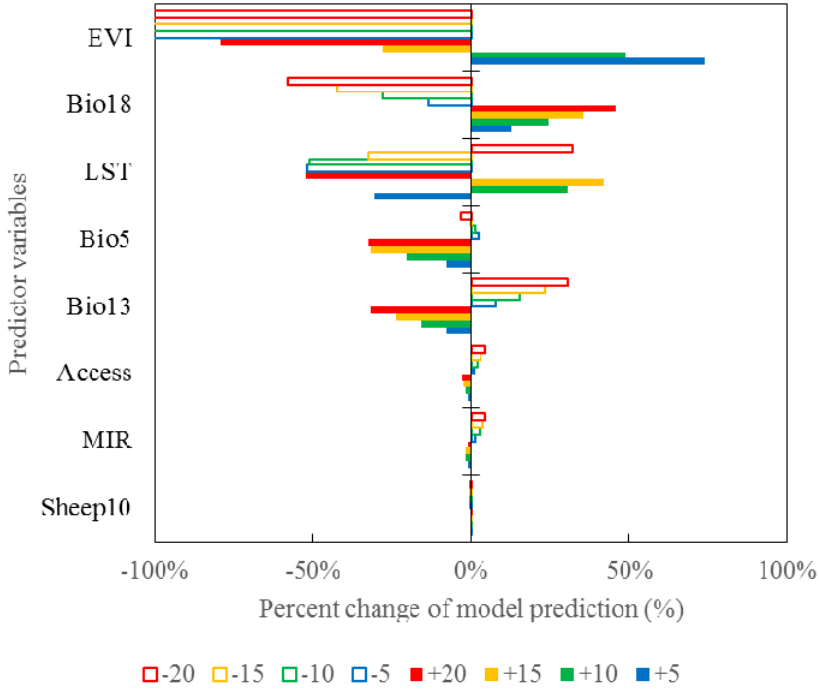
Figure 8. Sensitivity of ANN model to changes in predictor variables. Horizontal bars indicate the percent changes of model prediction caused by changes in the corresponding predictors. Positive values indicate overestimation while negative values indicate underestimation. The larger percent change of model prediction caused by changing a certain predictor, the more important that predictor is for model prediction.